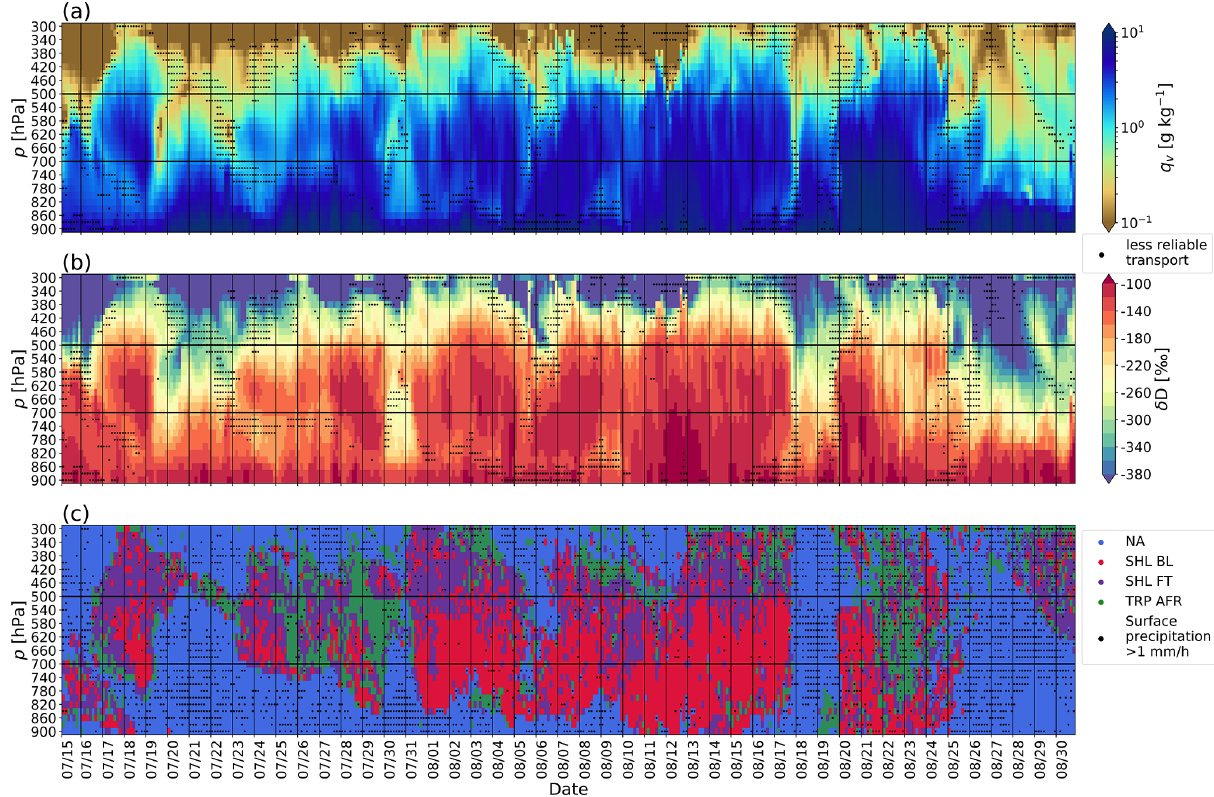
Figure 7. COSMO iso q v (a) and δ D in water vapour (b) 300–900hPa above Tenerife as well as the Lagrangian origin of the air parcels (c) . The black horizontal lines confine the horizontal air layer between 500–700hPa used for further analyses in this study. Black dots in (a, b) indicate a less reliable air parcel transport (see Sect. 2.4). Black dots in (c) represent transport pathways with surface precipitation equal or larger than 1mmh − 1 at least once over continental Africa for the African air parcels and over the North Atlantic for the North Atlantic air